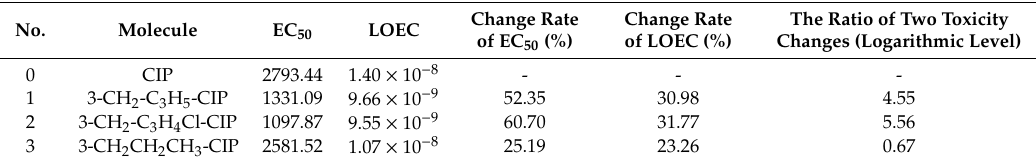
Table 7. Green algae toxicity, bacterial genotoxicity, and their enhancement ratio for CIP derivatives. No. Molecule EC 50 LOEC